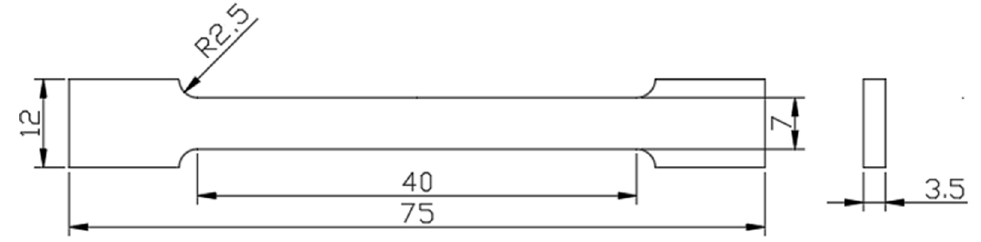
Figure 1. The size of test sample (units: mm).